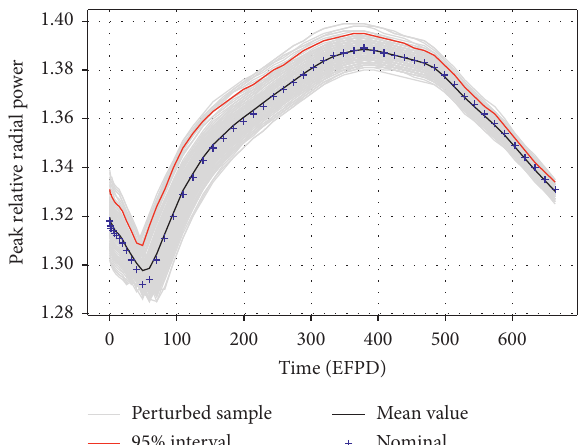
Figure 20: Peak relative assembly power of unperturbed and perturbed cases.